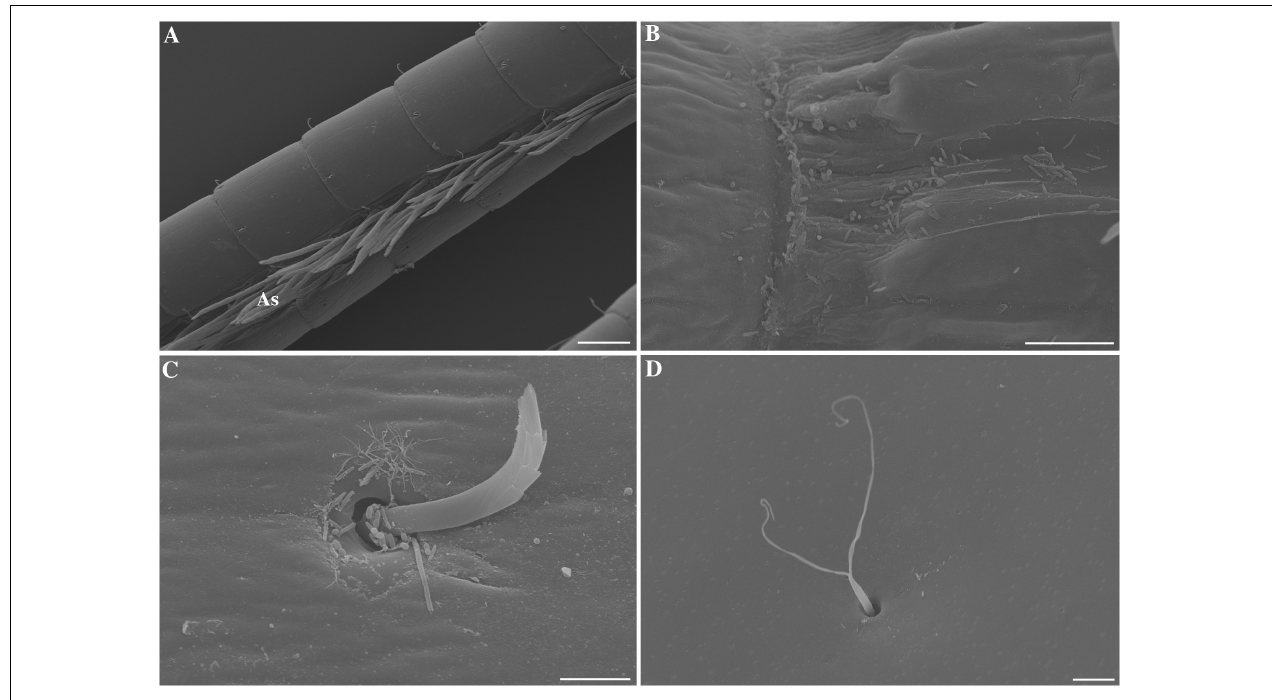
FIGURE 1 | Scanning electron micrographs of Palaemon elegans antennules, antennae and branchiostegite. (A) Lateral antennular flagellum bearing the aesthetascs (As). (B) Close-up of a intersegment of the antennae colonized by few rod-type bacteria. (C) Close-up of the base of a non-aesthetasc beaked scaly seta on the antennae. (D) Close-up of a bifid seta on the outer side of the branchiostegite showing no bacterial colonization. Scale bars: (A) = 100 µ m; (B) , (D) = 10 µ m; (C) = 5 µ